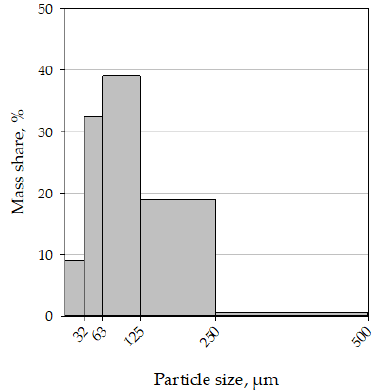
Figure 4. Particle-size distributions of the dust by sieving method.